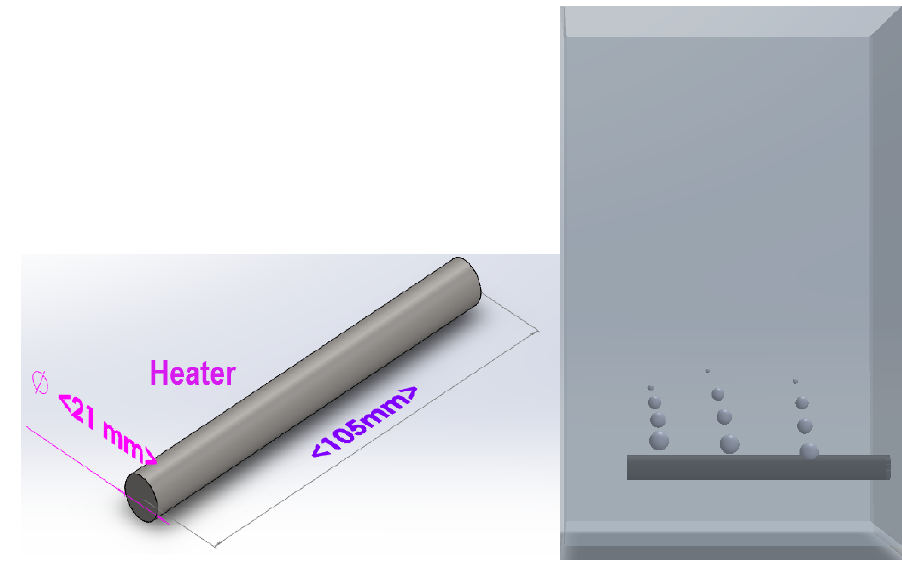
Figure 1. The schematic problem